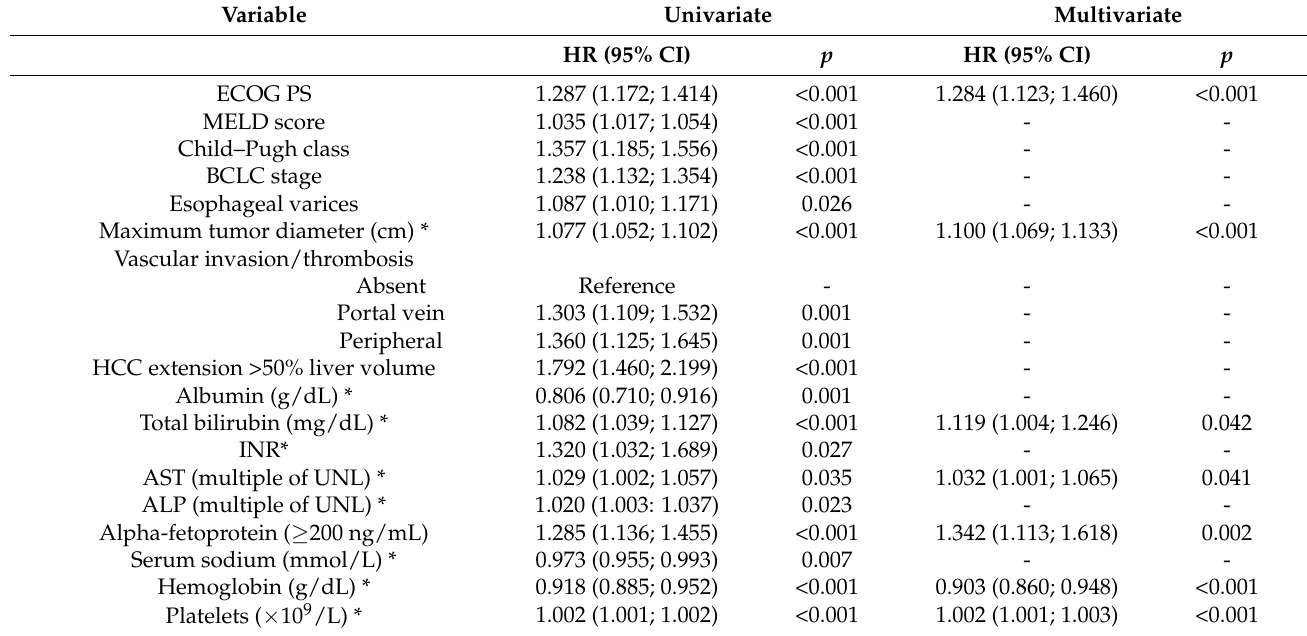
Table 2. Predictors of overall survival with statistical significance at the univariate and multivariate analysis.